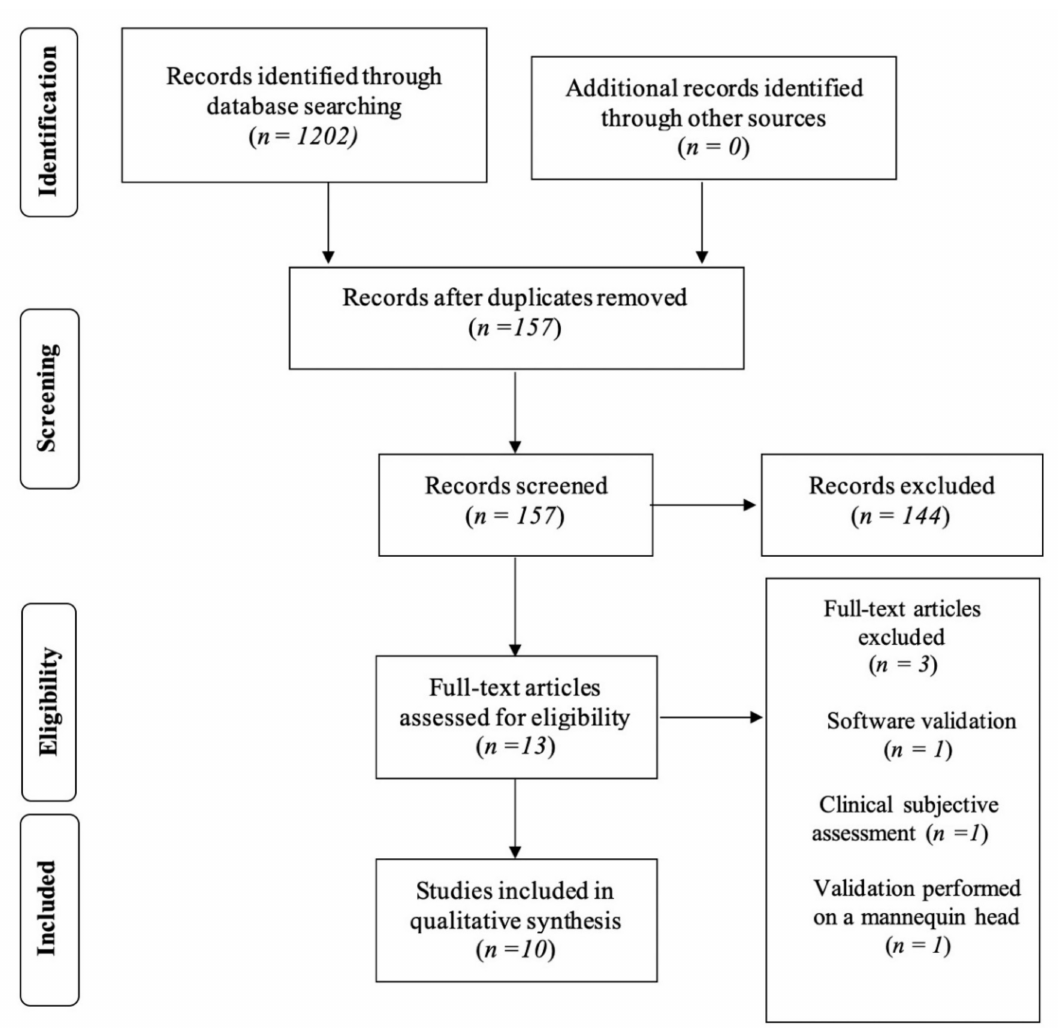
Figure 1. Summary of the phases of study selection showing the number of studies identified, screened, eligible and included in the present